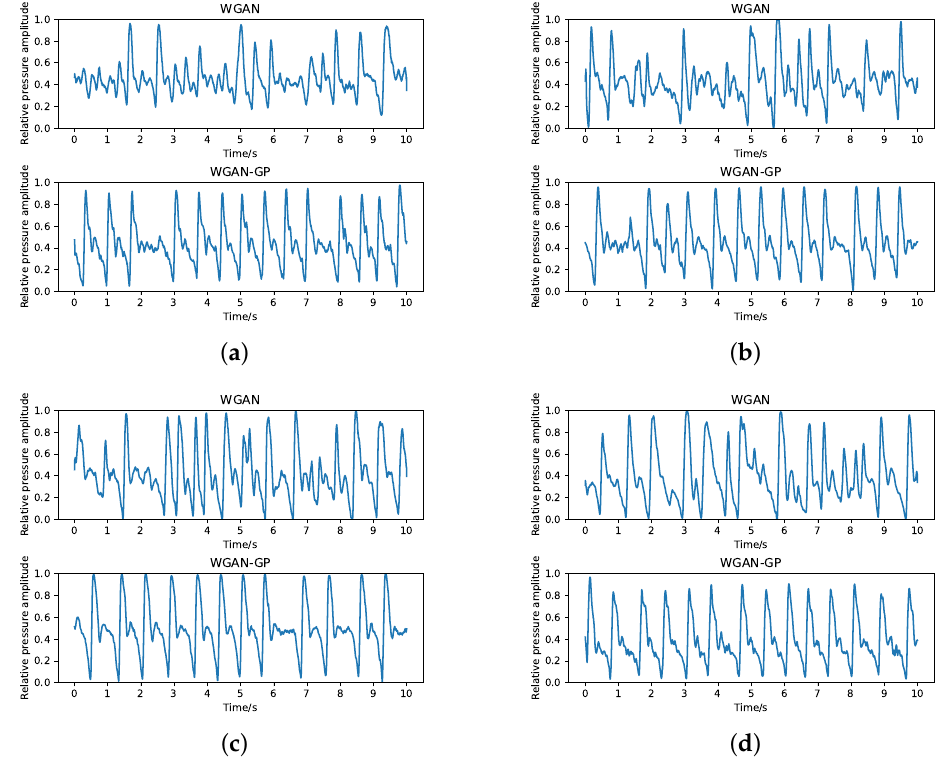
Figure 6. Examples of time series pair generated from WGAN and WGAN-GP models for associated epochs, respectively: ( a ) 500 epochs; ( b ) 1000 epochs; ( c ) 1500 epochs; ( d ) 2000 epochs. In every subfigure, the top is the simulated pulse generated by WGAN and the bottom is the simulated pulse generated by